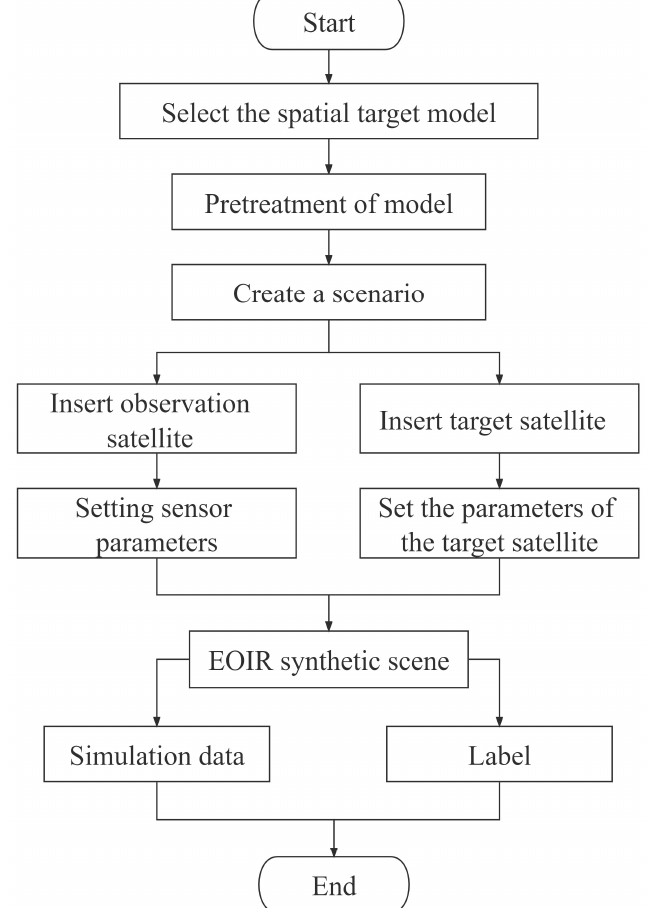
Figure 2. Flowchart of physical simulation of orbit.